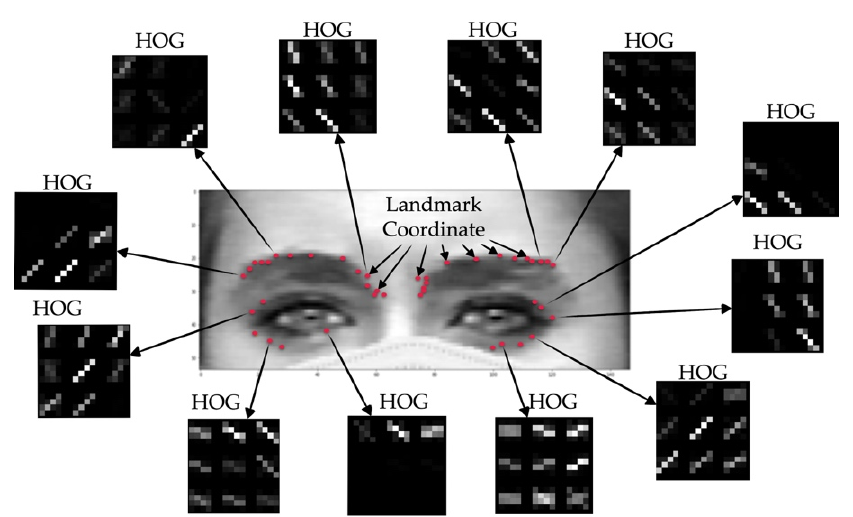
Figure 11. Example of the HOG features of each detected landmark, the HOG feature vector, and the algorithm. Algorithm 2: Histogram of Oriented Gradient (HOG)